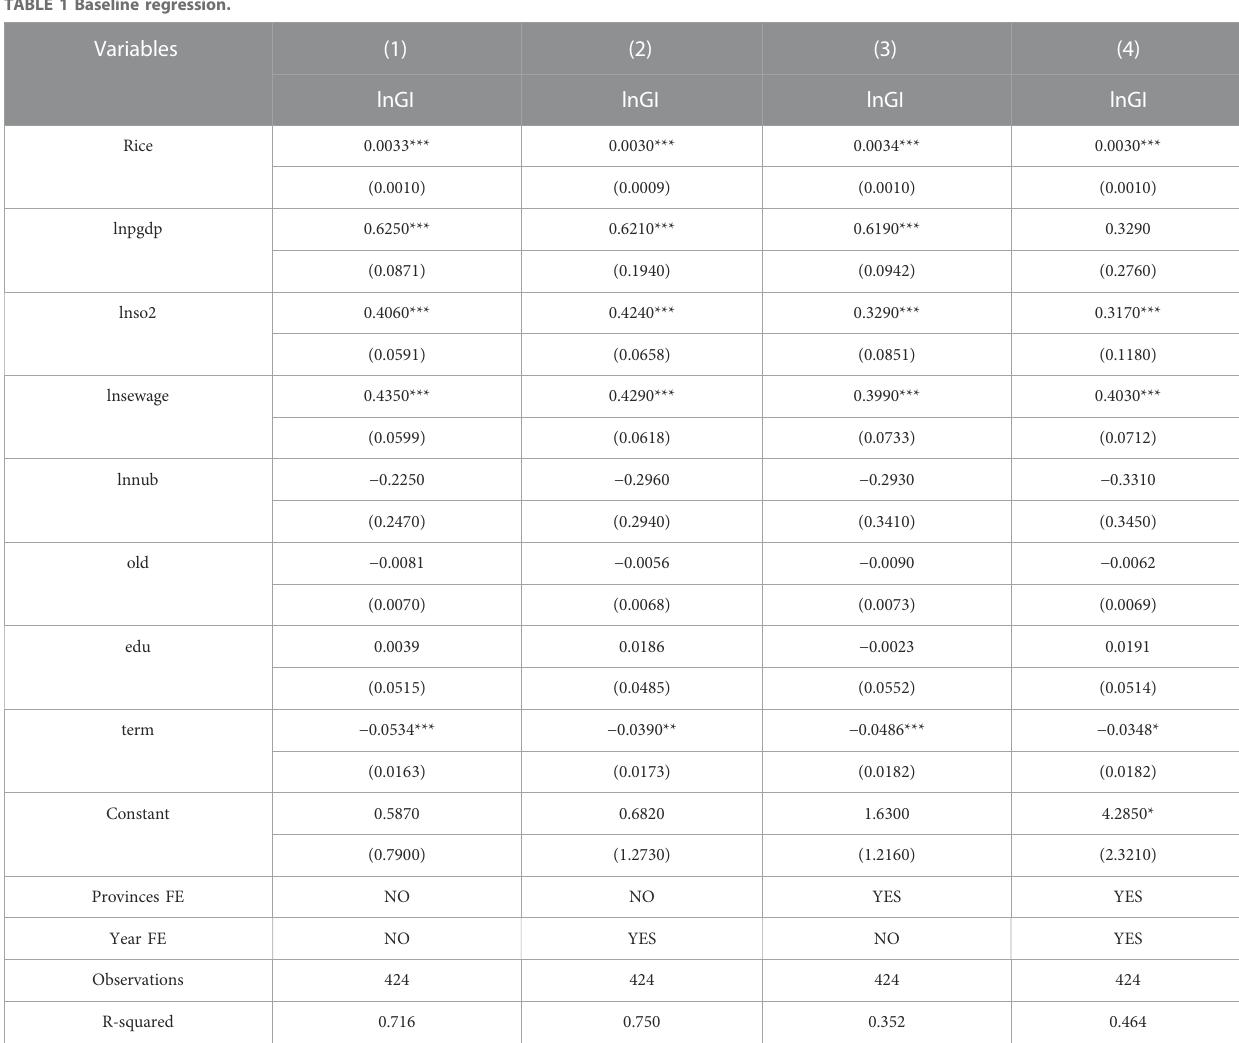
TABLE 1 Baseline regression.